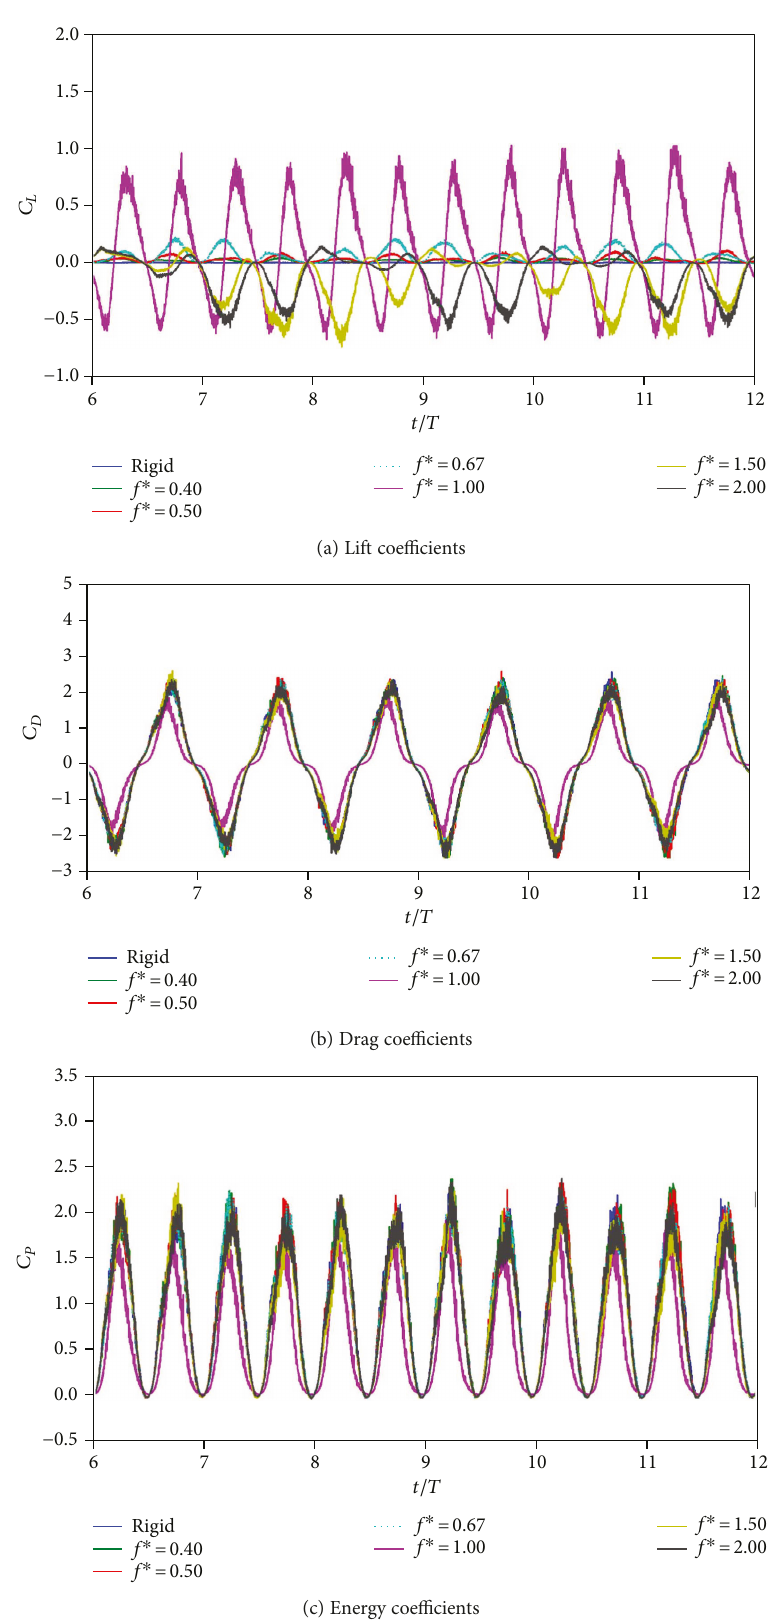
Figure 8: Time variation of the lift coe ffi cients, drag coe ffi cients, and energy coe ffi cients of the 3D lumped fl exibility wing with di ff erent f ∗